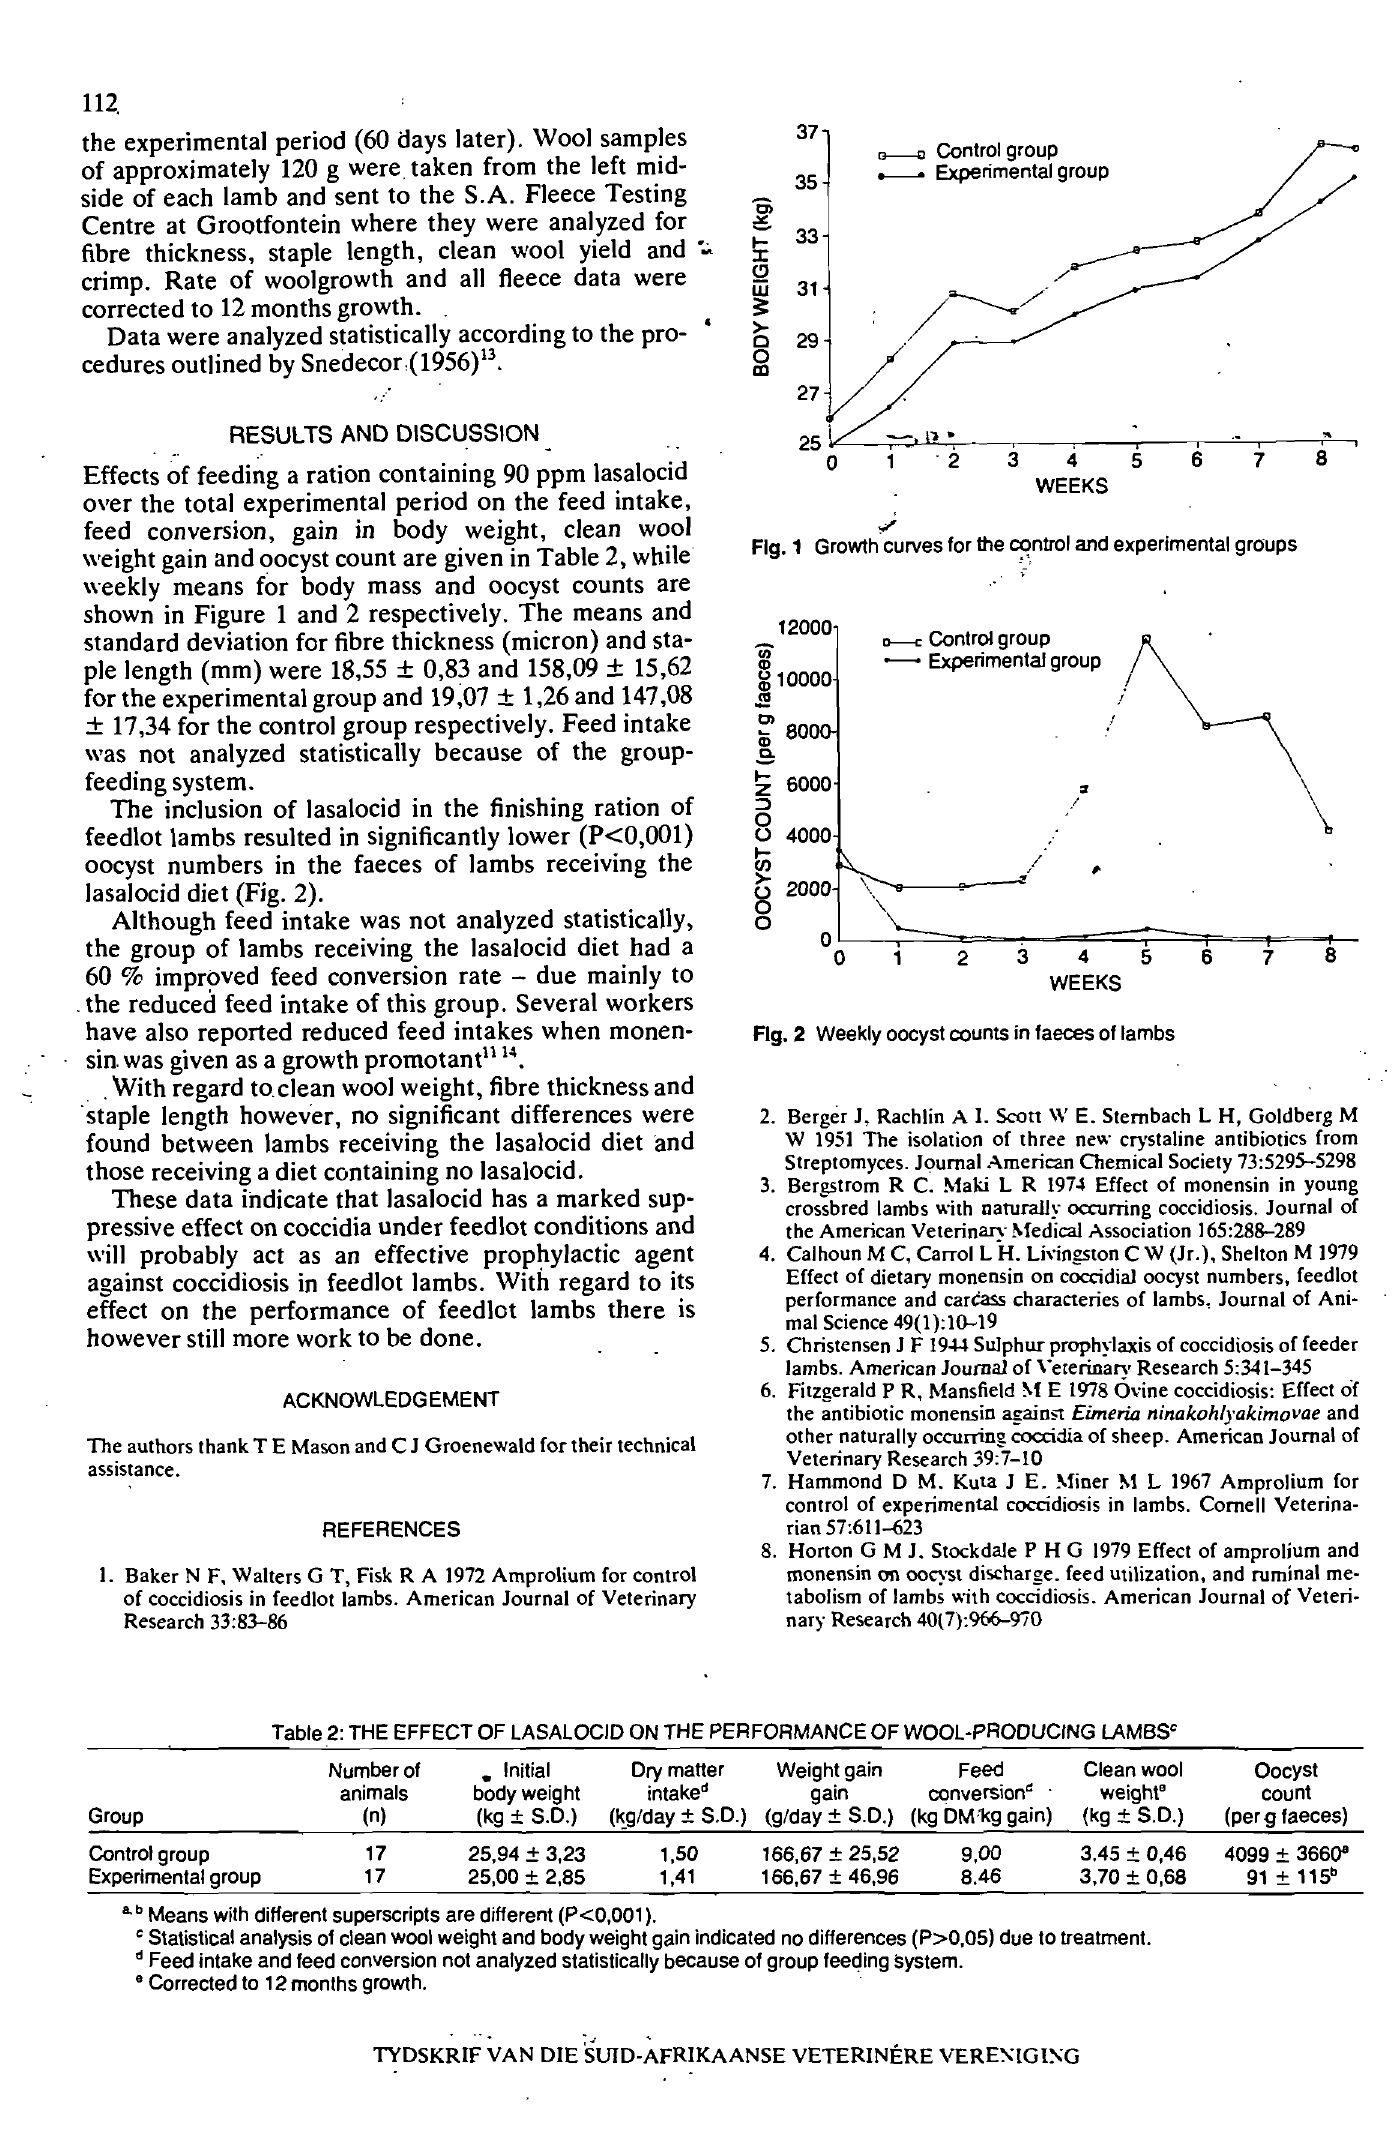
.." Fig. 1 Growth'curves for the '7!ntrol and experimental groups